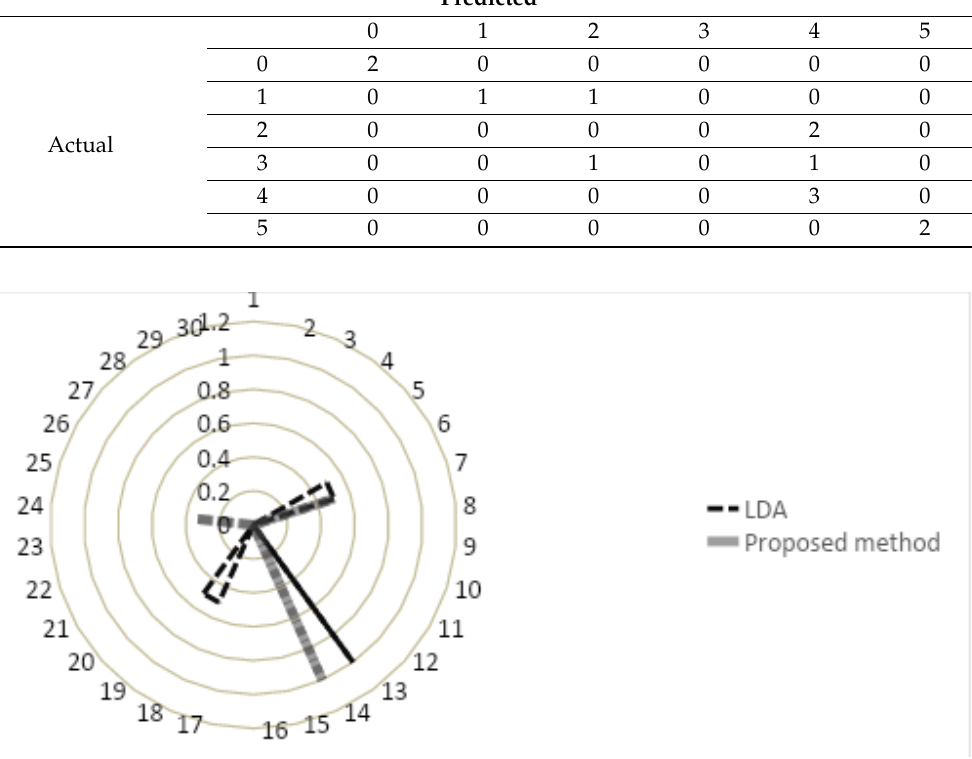
Figure 4. Cobweb graphical representation of LDA and our proposed method. Table 13. p -values of the different